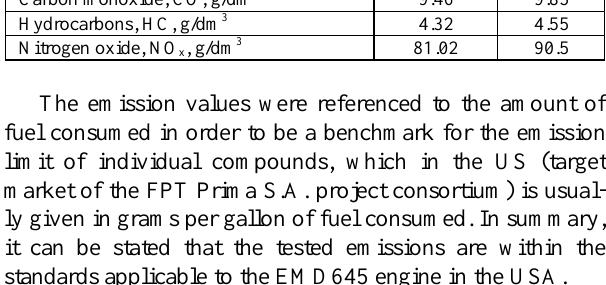
Table 5. Emission value of the toxic exhaust components of an EMD 645 engine before and after the team endurance test Chemical compound measured Emission Emission before test after test Sulfor dioxide, SO 2 , ppm